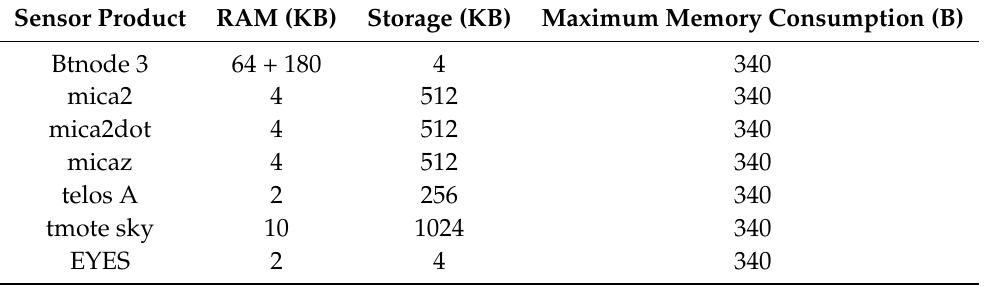
Table 4. Memory size of each sensor product and memory consumption for the proposed scheme.